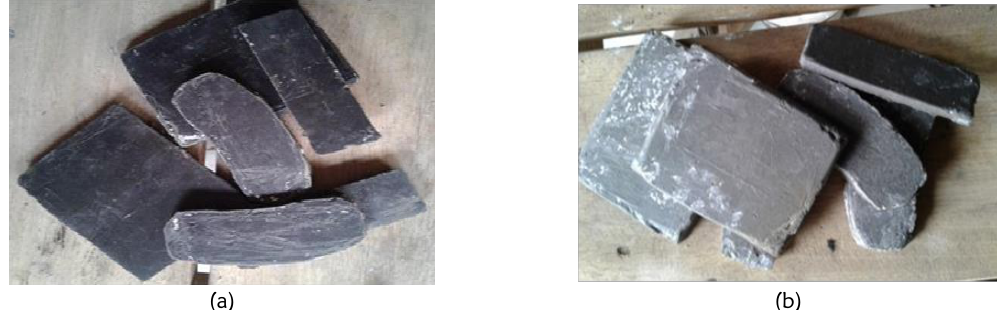
Figure 8: Heat treated samples (a) Coconut shell-based composite and (b) Seashell-based composite